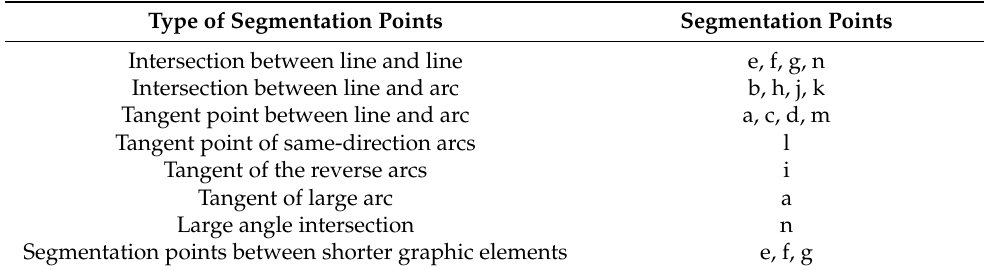
Table 2. Categories of segmentation points.